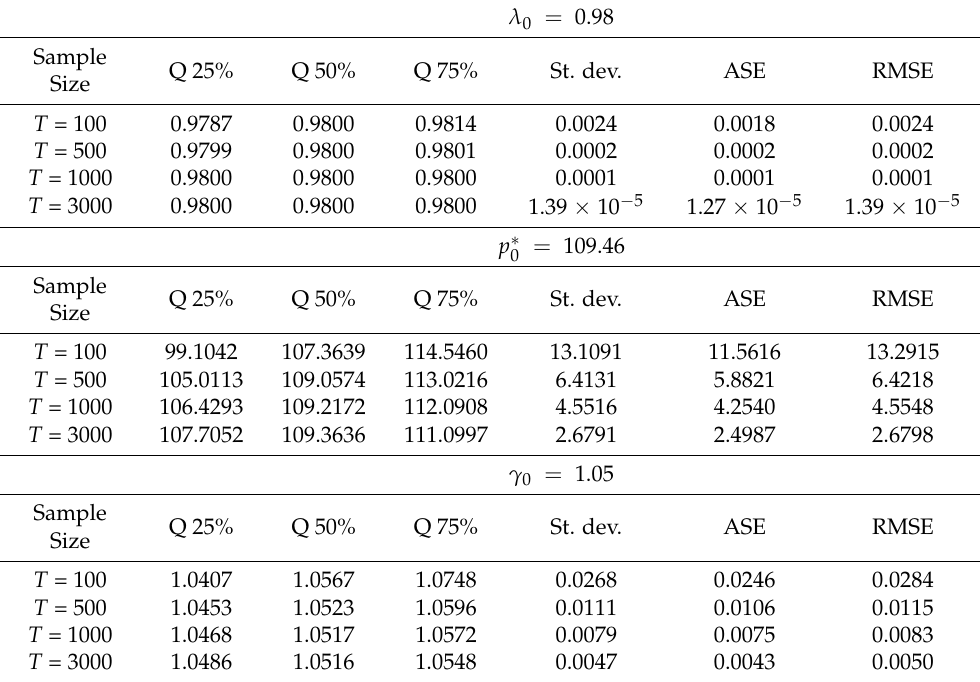
Table 1. Inverse consumption demand F(C) = 600 − 5C. True parameter values are λ 0 = 0.98, = 109.46, γ = 1.05. p ∗ 0 0